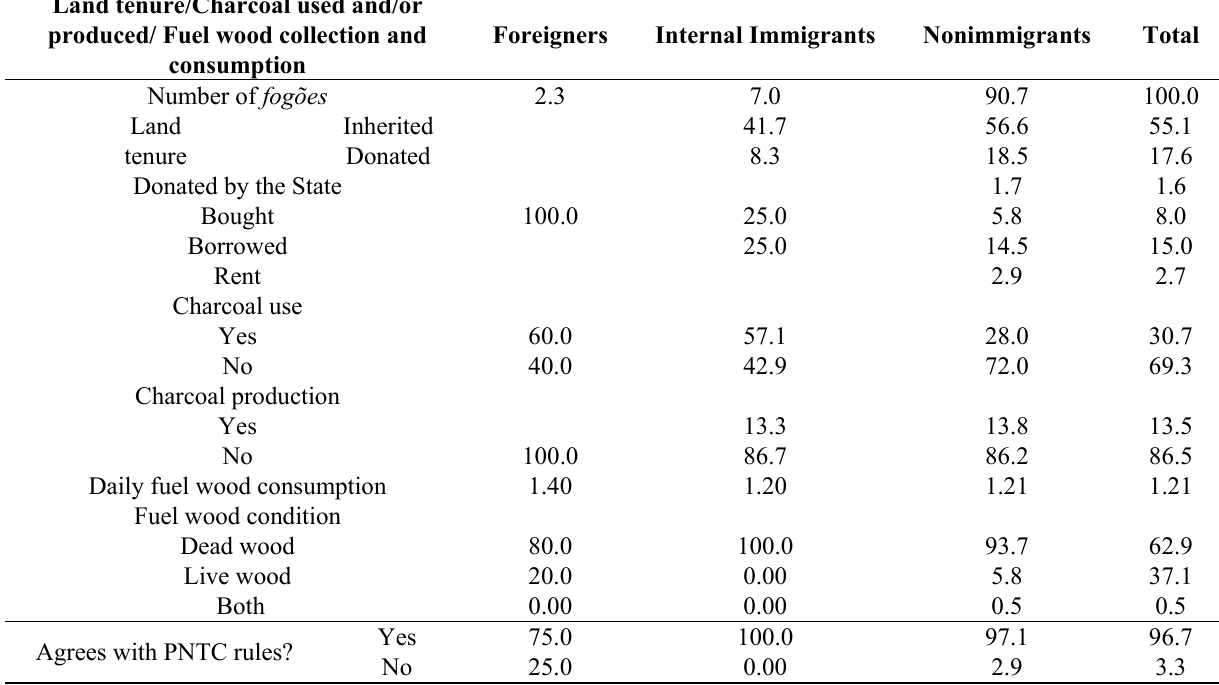
Table 6. Immigrants vs. nonimmigrants and land